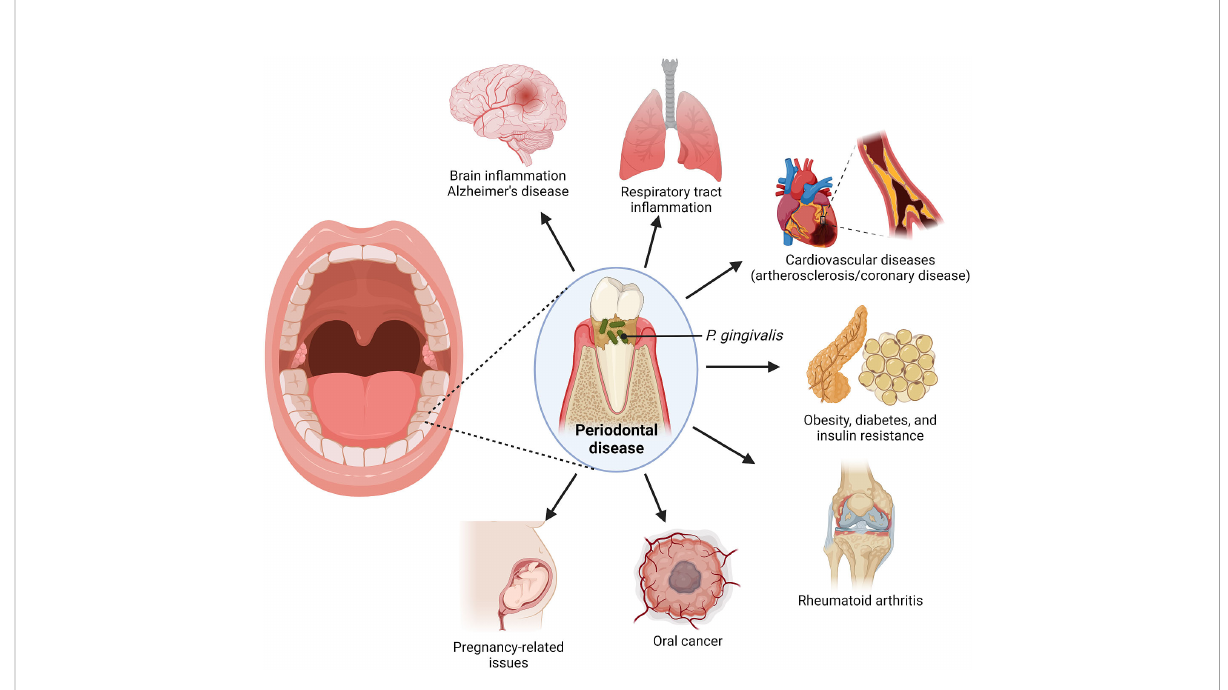
FIGURE 1 Link between P. gingivalis , an oral pathogen, with various systemic diseases.